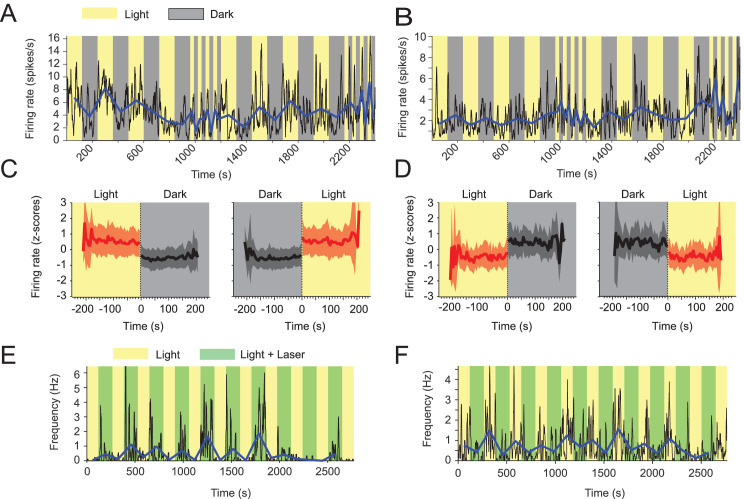
Visual inputs alter mean firing rates of neurons in the medial entorhinal cortex.(A-D) Yellow and gray backgrounds indicate duration of light and dark epochs, respectively. (A) Data on firing rate from one example neuron in the medial entorhinal cortex (MEC) with its baseline firing rate negatively modulated by darkness. Black lines show the firing rate at 1 s resolution. Blue line connects the mean firing rate in each light or dark epoch. (B) Data on firing rate from one example neuron in the MEC whose baseline firing rate is positively modulated by darkness; same visualization scheme as in A. (C) Left and right panels show the mean z-scored firing rate across n = 139 neurons with significantly negative modulation of firing rates by darkness (see Materials and methods) in 5 s bins around the transition point from light to dark and dark to light, respectively. Red color indicates data from the light condition, black and gray color indicate data from the dark condition. Solid lines and shaded areas show mean and SD. (D) Same as C, but for neurons with positive modulation of baseline firing rates by darkness; n = 32. (E, F) Yellow background indicates light condition, green background indicates the presence of an egocentrically stable spot of green laser light above the animal’s head during the standard light condition. (E) Data on one example neuron in the MEC showing positive modulation of baseline firing rate in presence of the green laser light spot. Same visualization scheme as in A and C. (F) As in E, but for one example neuron with negative modulation of baseline firing rate. Mean firing rates and running speed-adjusted mean firing rates of neurons during light and dark conditions are provided in Figure 4—source data 1.Figure 4—source data 1.Data table of mean firing rates and running speed-adjusted mean firing rates during light and dark conditions of the 171 neurons with significant modulation of firing rates by visual inputs.